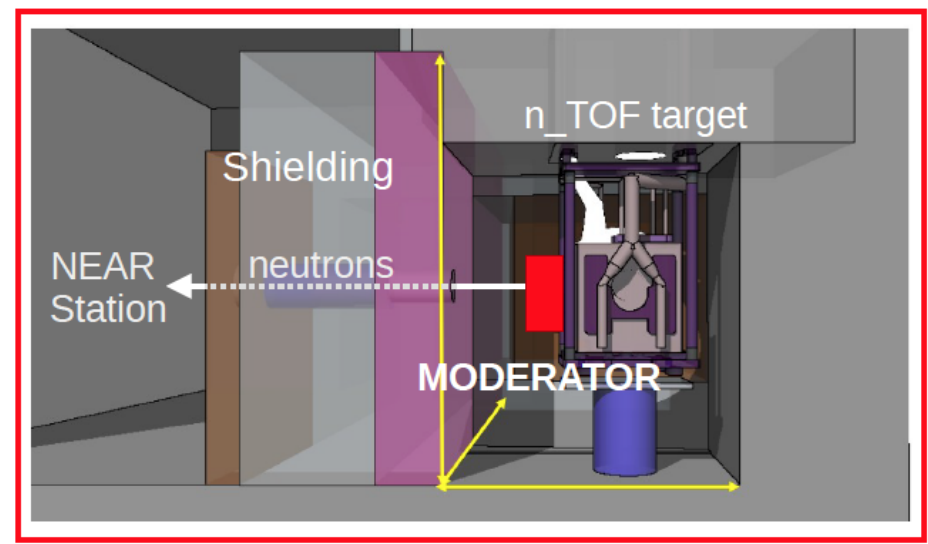
Figure 4. Schematic drawing of the spallation target and the possible position of a moderator (block in red).